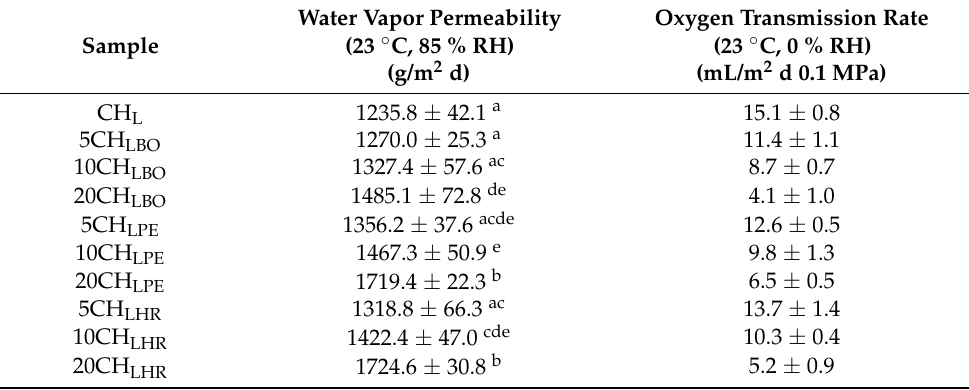
Table 5. Gas barrier properties expressed as water vapor transmission rate and oxygen